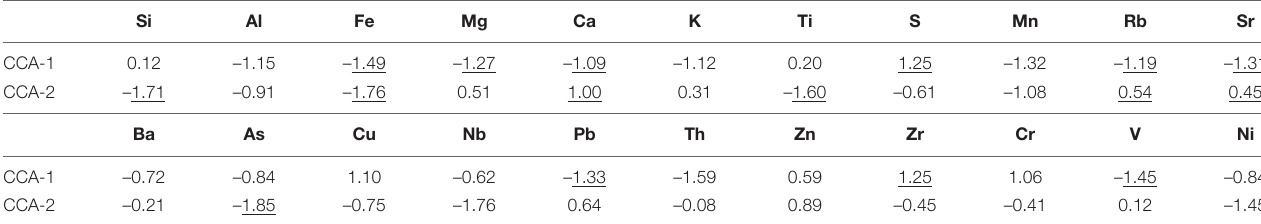
TABLE 5 | Spearman Rank Order correlations analysis between total foraminiferal assemblages and geochemical data from three (KPF1, KPF2 and REF) sampling stations (marked correlations are significant at p <